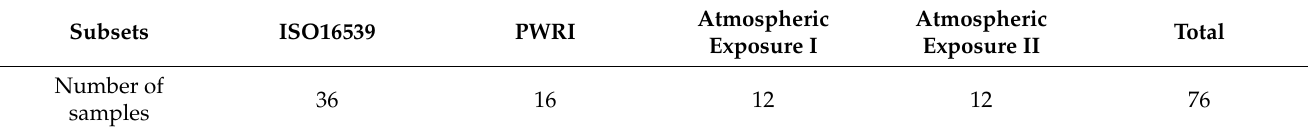
Table 1. Corrosion Dataset.